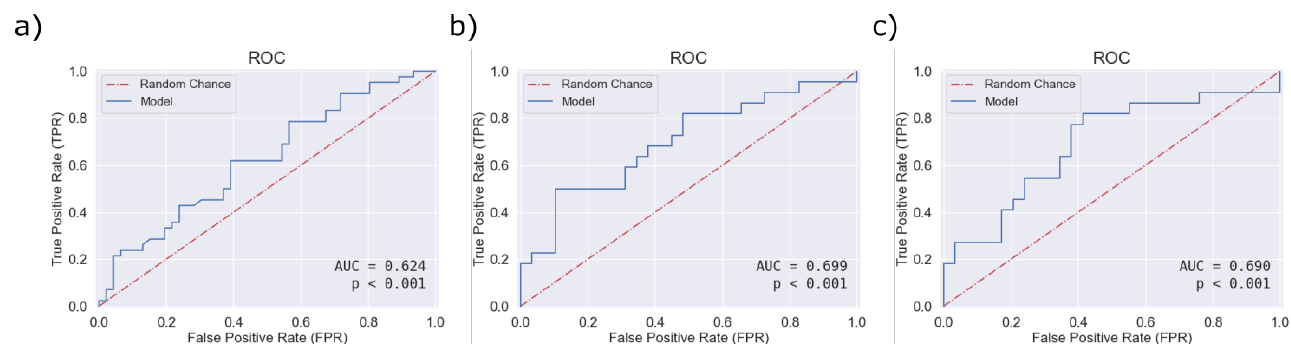
Figure 8. ROC curves for the considered external validations. ( a ) External validation of the SVM classifier (5 features) trained on D1 and validated on D2. ( b ) External validation of the AdaBoost classifier (7 features) trained on D1 and validated on D3. ( c ) External validation of the AdaBoost Classifier (10 features) trained on the merged dataset D1, D2 and validated on